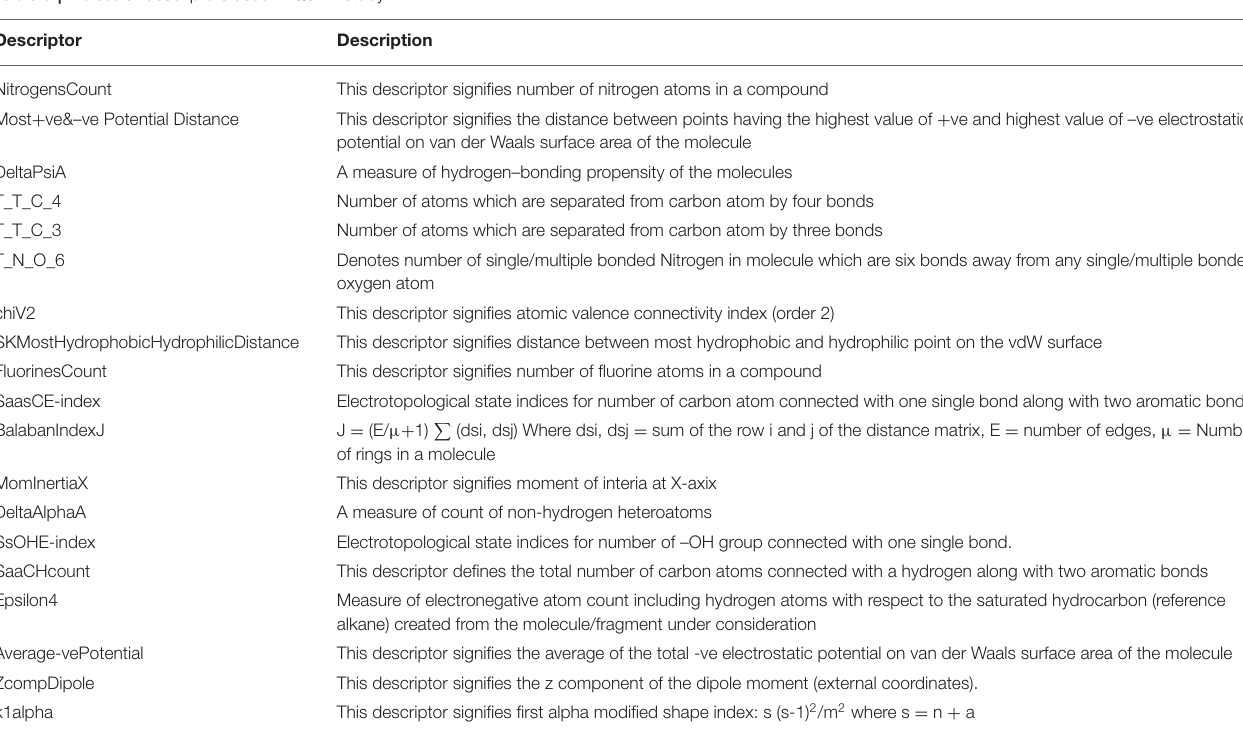
Table 5 | Molecular descriptors used in QSAR